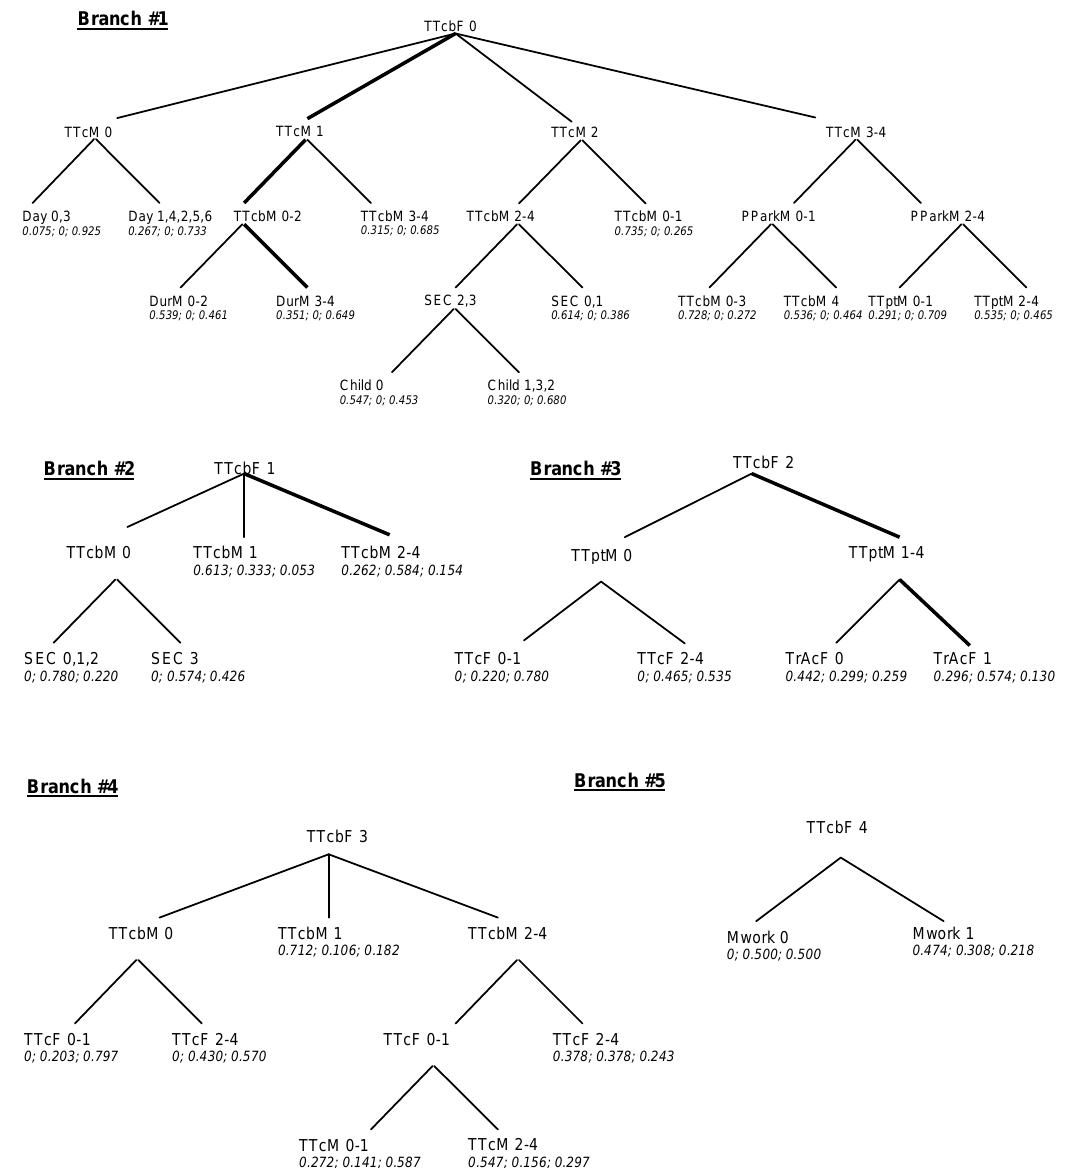
Figure 4. Car Allocation Tree Model with 5 Major Branches As another example, in branch #2, the rule printed in bold indicates that IF travel time ratio between car and bike for female is less than 0.30 (relatively good accessibility by car) AND the travel time ratio between car and bike for male is at least 0.26 (relatively good accessibility by bike), THEN the probability of female getting the car (26.2%) is yet lower than that of male (58.4%). This rule indicates that even if the male’s work place is well accessible by bike, the propensity of the male to use the car is considerably higher than that of female. Furthermore, in branch #3, as another example, the rule printed in bold indicates that IF the female and male both have a work activity and the travel time ratio between car and bike for the female is in between 0.31 and 0.42 (the car is between 3.2 and 2.4 times faster than bike) AND travel time ratio between public transport and car of male is greater than zero AND there is a train connection